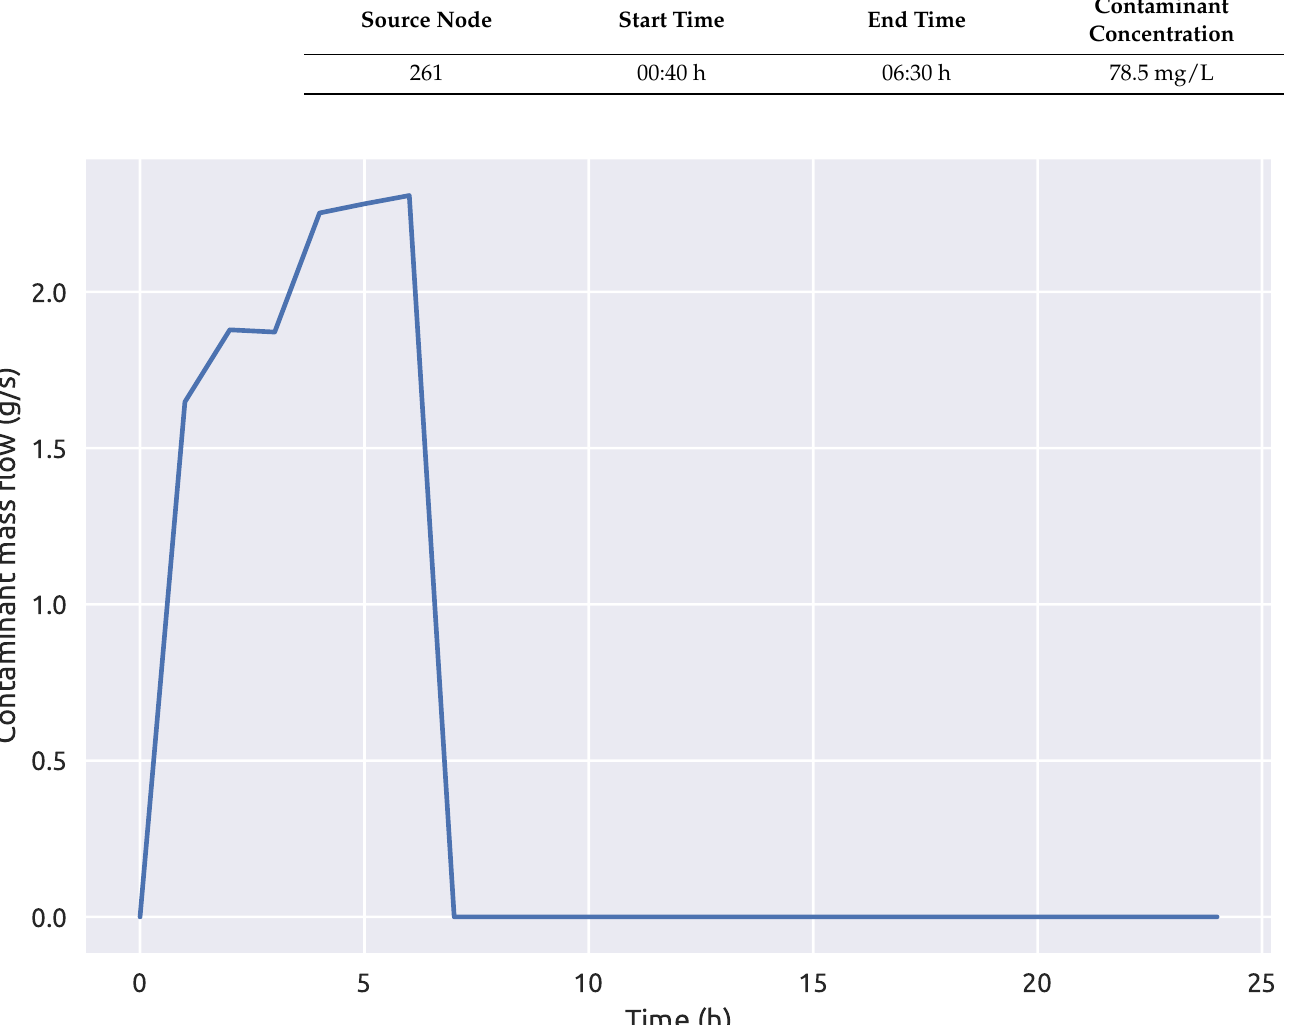
Figure 8. Average contaminant mass flow at the source node 261 over a 24 h period. A parameter tuning process was also done for all of the three investigated algorithms through a grid search process. For each parameter combination of the three algorithms, a total of 100 repeated runs were made due to their stochastic nature. The performance was measured as the number of successful runs (cases in which all of the three optimization variables were predicted correctly with a fitness value below 0.02) out of 100 and the average time per run. A total of 256 parameter combinations were examined for